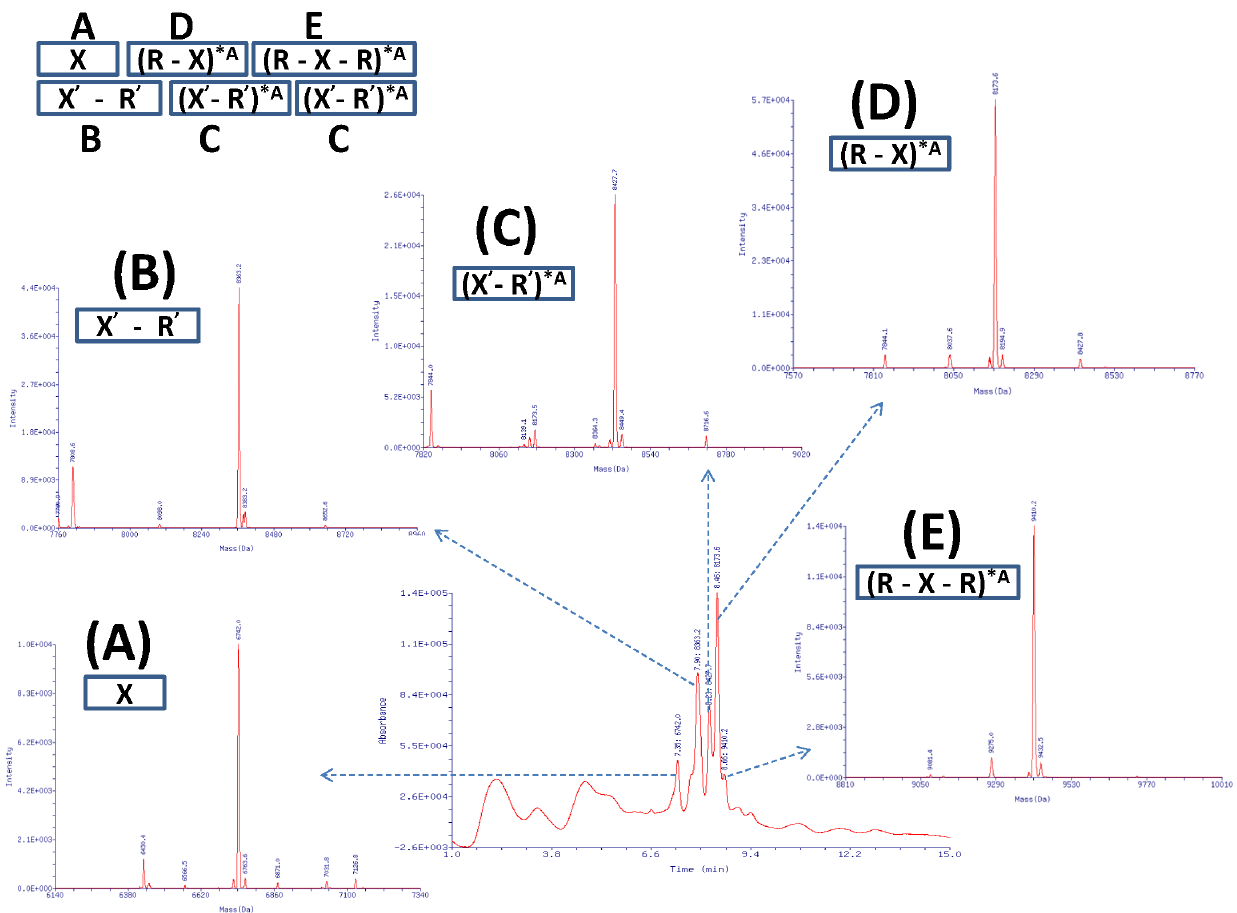
Figure 3. The LC/UV Chromatogram and Deconvoluted Mass Spectrum of the *A PEAR product. Components: (A) RT=7.35 min: MW=6742.0; (B) RT=7.90 min: MW=8363.2; (C) RT=8.23 min: MW=8427.7; (D) RT=8.46 min: MW=8173.6; (E) RT=8.66 min: MW=9410.2; See Table S1 in File S1 for detailed characterization of components.